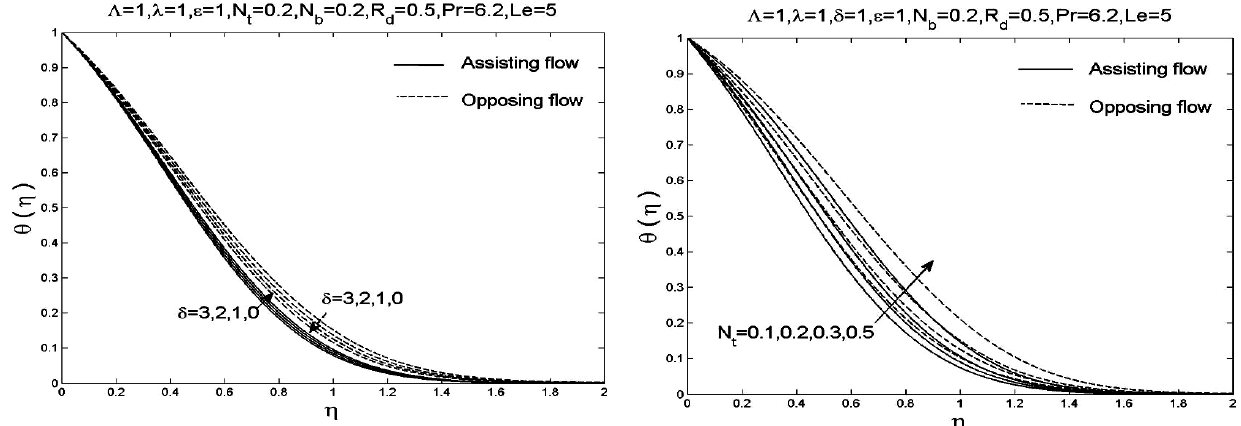
Fig. 13. The effect of the solutal buoyancy parameter δ on the temperature profiles ( ) θη .